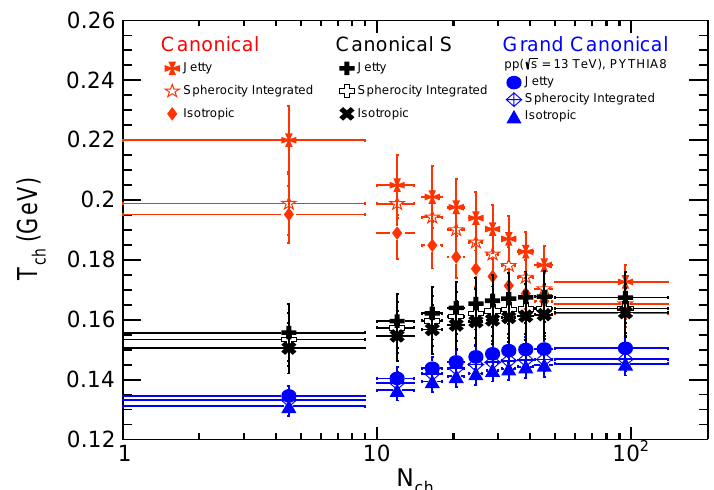
Figure 7. The chemical freeze-out temperature as a function of charged particle multiplicity ( N ch ) for the canonical, strangeness canonical, and grand canonical ensembles. The red and black points are obtained using the canonical ensemble and the strangeness canonical ensemble, respectively, whereas the blue points are for the grand canonical ensemble.